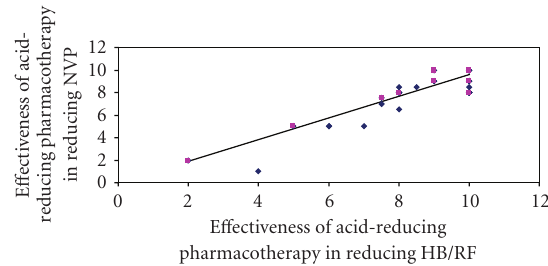
Figure 3: Linear regression comparing the e ff ectiveness of acid- reducing pharmacotherapy in reducing HB/RF, and in reducing NVP. Women rated e ff ectiveness from zero (no e ff ect) to 10 (maximal e ff ect); R 2 = 0 . 72, P < . 001